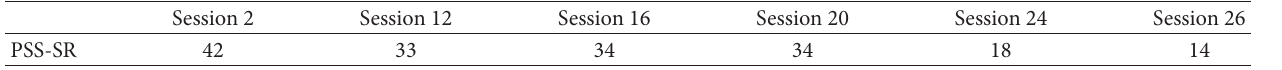
T 3: Results of the ongoing monitoring of treatment efficacy during treatment.